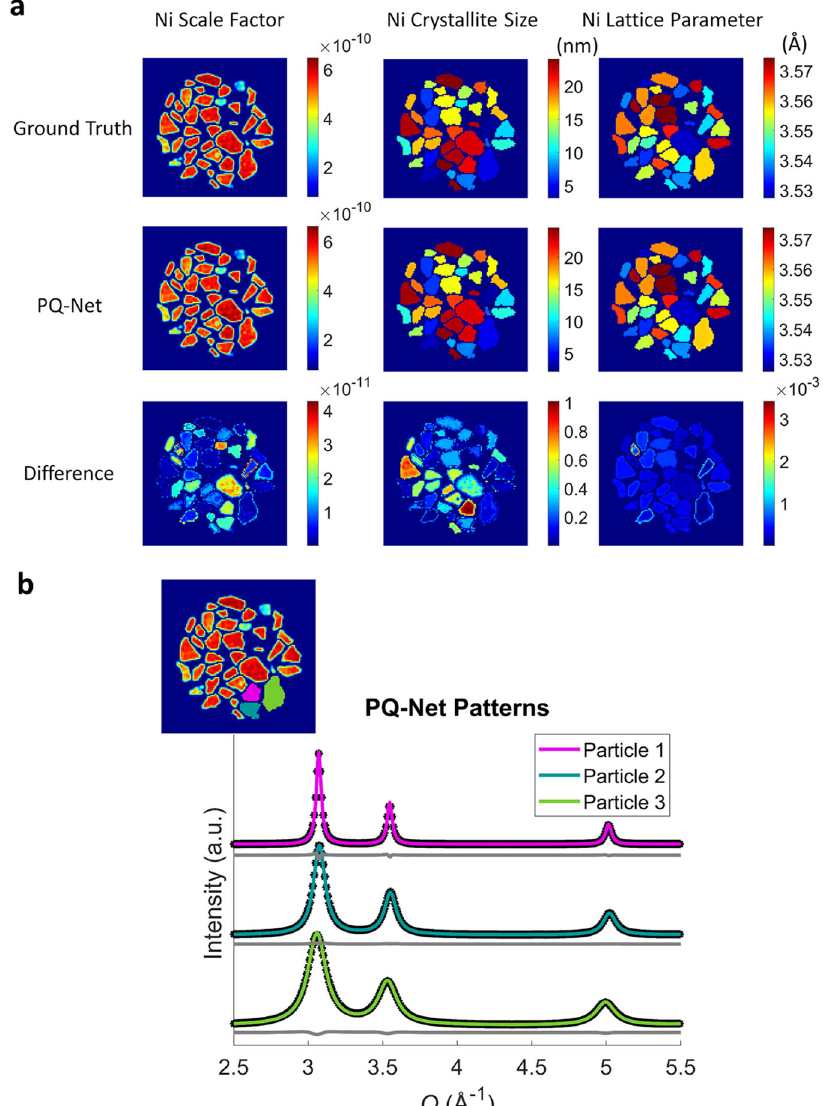
Fig. 2 PQ-Net results for the single-phase simulated data. a Ni scale factors, crystallite sizes (nm) and lattice parameter ( Å ) ground truth maps, results obtained with the PQ-Net and their absolute difference. b Comparison between the average diffraction patterns extracted from three particles of interest and the TOPAS generated patterns using the parameters predicted by the